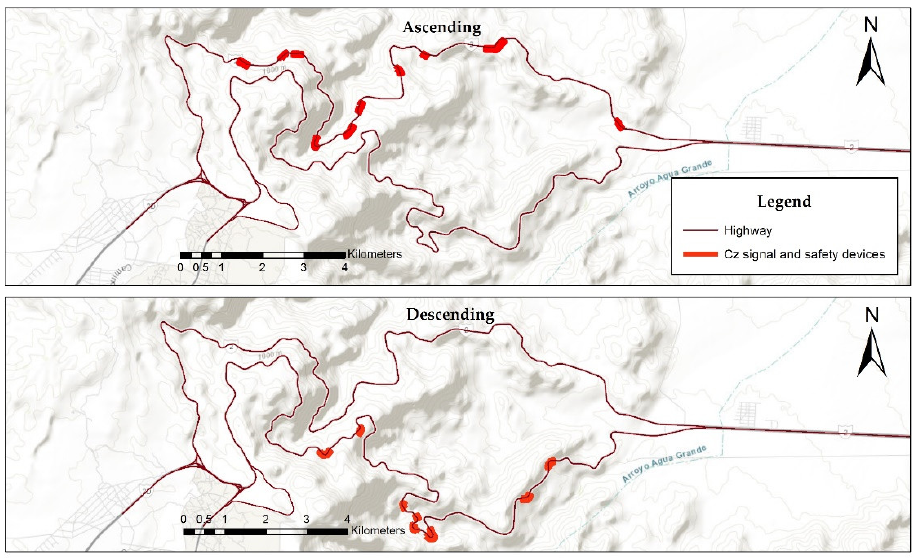
Figure 7. Tra ffi c signals and safety devices condition in mountain Figure 7. Traffic signals and safety devices condition in mountain zone.